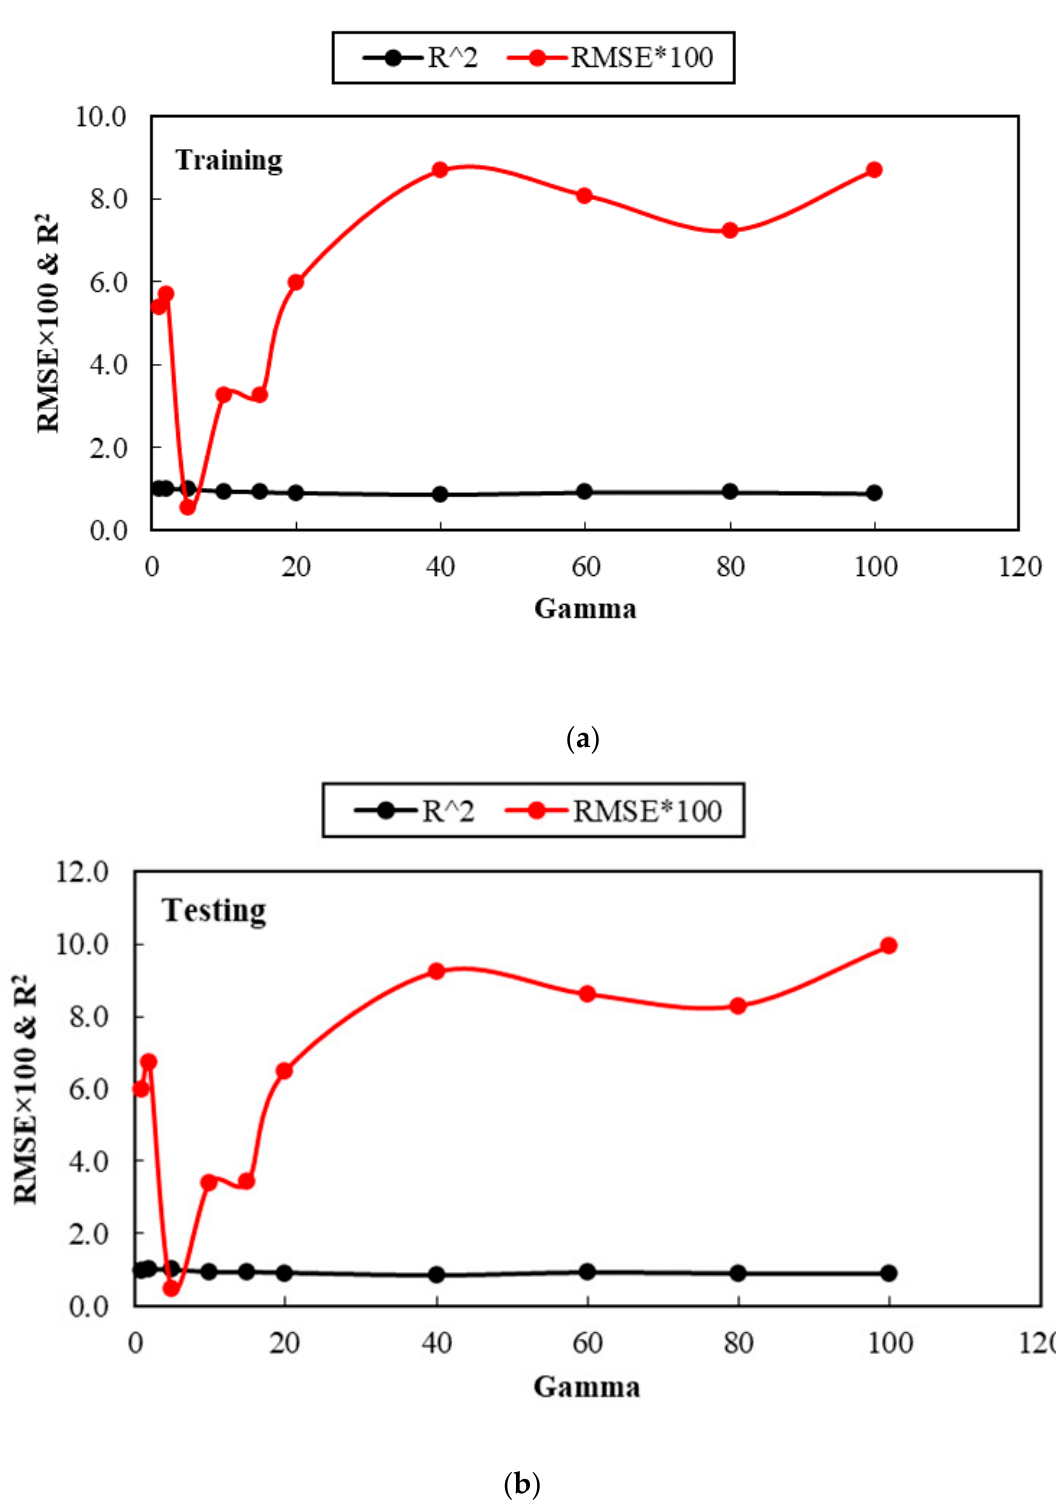
Figure 4. Variation of RMSE and R 2 vs. Gamma values for best model in the first scenario; ( a ) training, ( b ) testing.